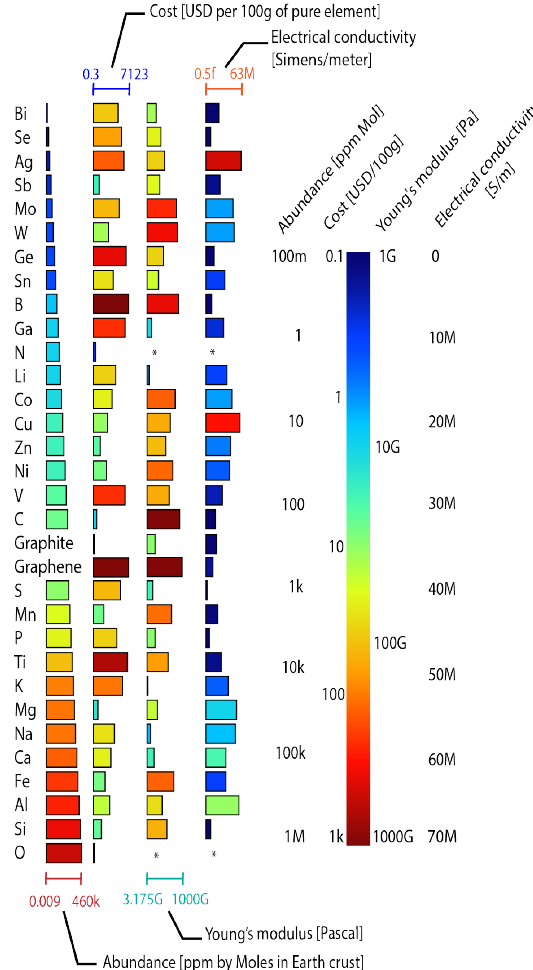
Figure 4. Elements used in battery manufacturing organized from low to high availability. The first column represents the abundance in the earth’s crust. The second shows the cost per 100g of the pure element. The third represents the Young modulus. The fourth shows the electrical conductivity. The length of the bars is normalized between the lowest and highest value for each parameter. The * symbol indicates that there is no value. Graph constructed by the authors. Data from